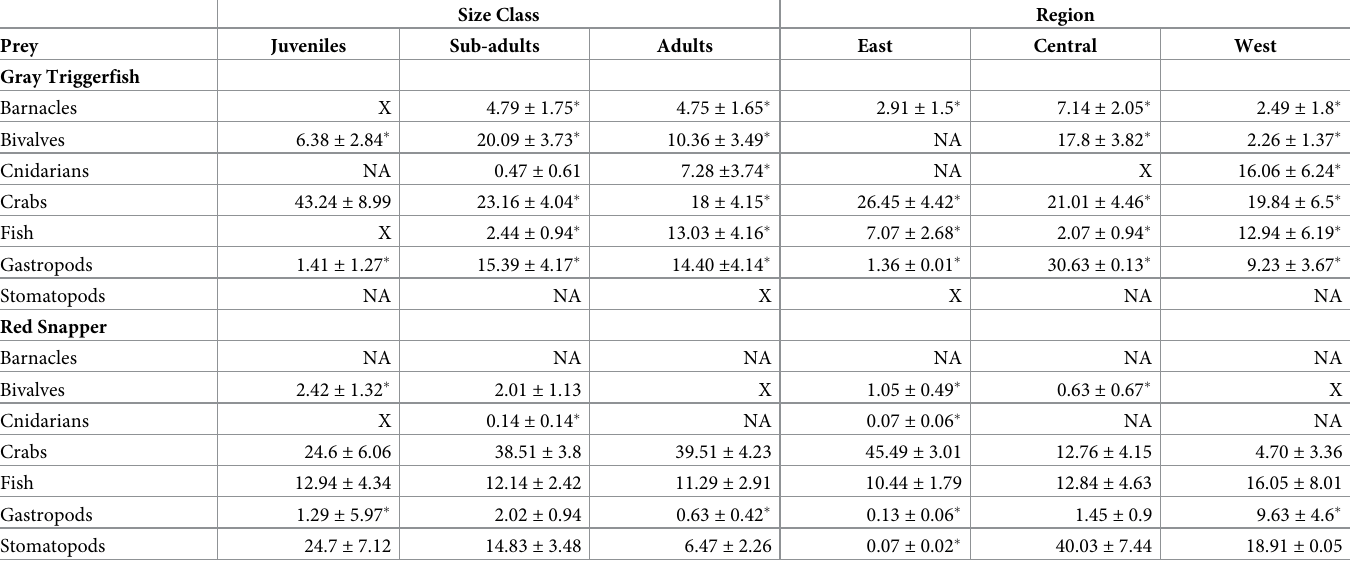
Values shown are prey group % contribution estimates along with the standard error for each size class, species, and region. An ‘X’ indicates an insufficient number of guts containing the prey item within the sample, where the model could not be applied. An ‘NA’ signifies that the prey item was not present in the sample, and a ‘ (cid:3) ’ indicates results obtained using the reduced